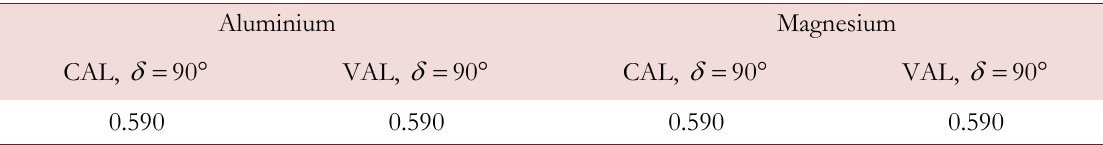
Table 6: Correlation-based non-proportionality factor,